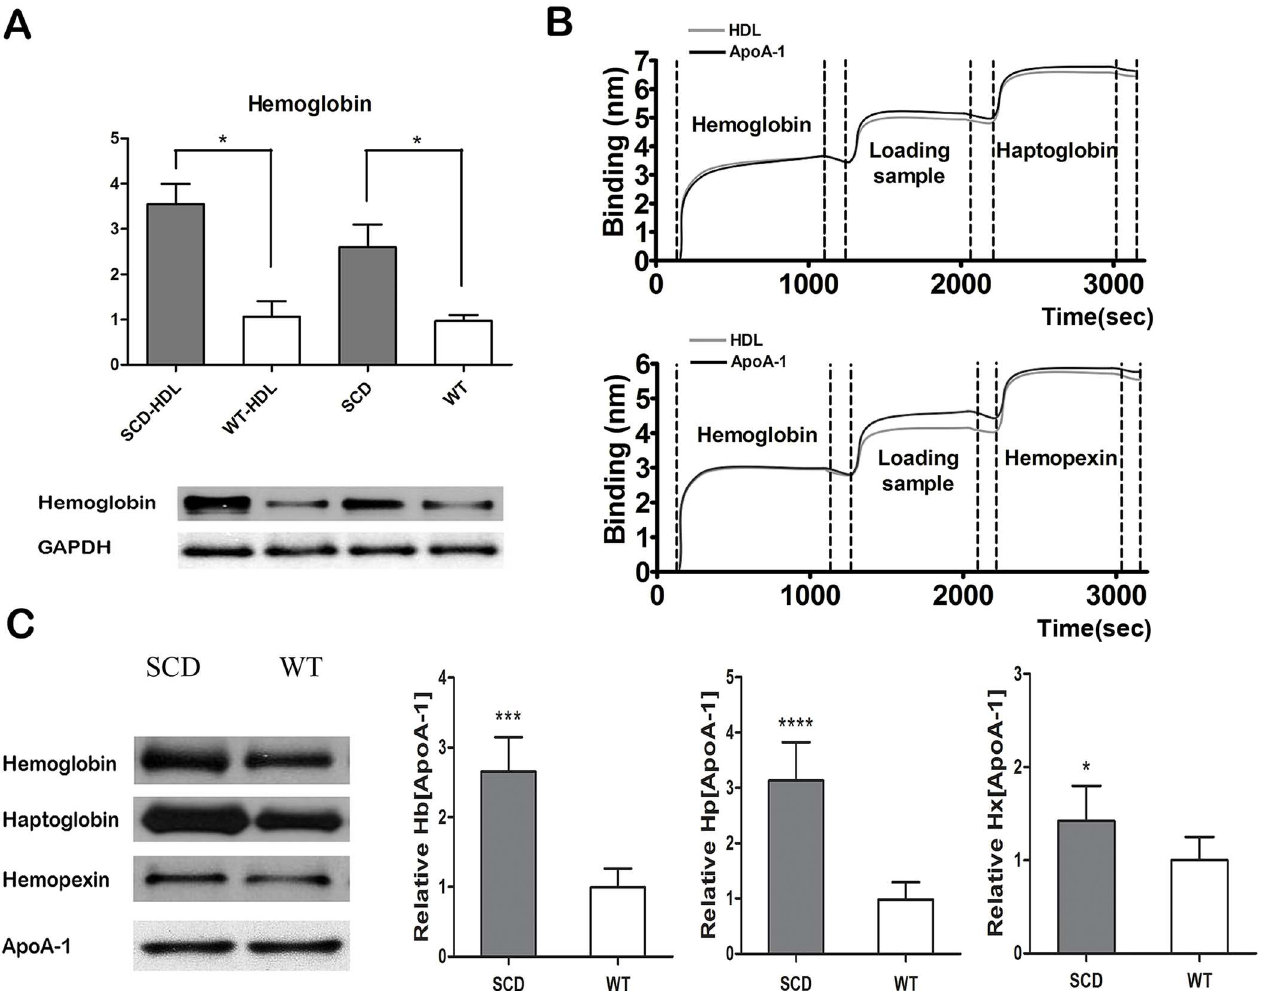
Fig 4. The association of Hb/Hp/Hx complexes with HDL in SCD mice. (A) Cell-free hemoglobin(cf-Hb) or associated Hb was elevated in the HDL or plasma of SCD mice compared to wild-type (WT). (B) The curve in the Octet system shows HDL had its associationfor Hp (upper) and Hx (lower) on the basis of HDL/ApoA-1 inside HDL. Hemoglobin/Haptoglobin/ Hemopexin = loadingbiotin-labelled Antibody of Hemoglobin/ Haptoglobin/Hemopexin. It suggests that Hb/Hp/Hx association has a strong relationshipwith ApoA-1 particles in HDL. (C) The result of immunoprecipitation and immunoblot analysisshow that Hb, Hp and Hx associated with ApoA-1 was increasedunder conditionsin which ApoA-1 was at the same level in both groups. * p < 0.05; *** p < 0.001; **** p < 0.0001.